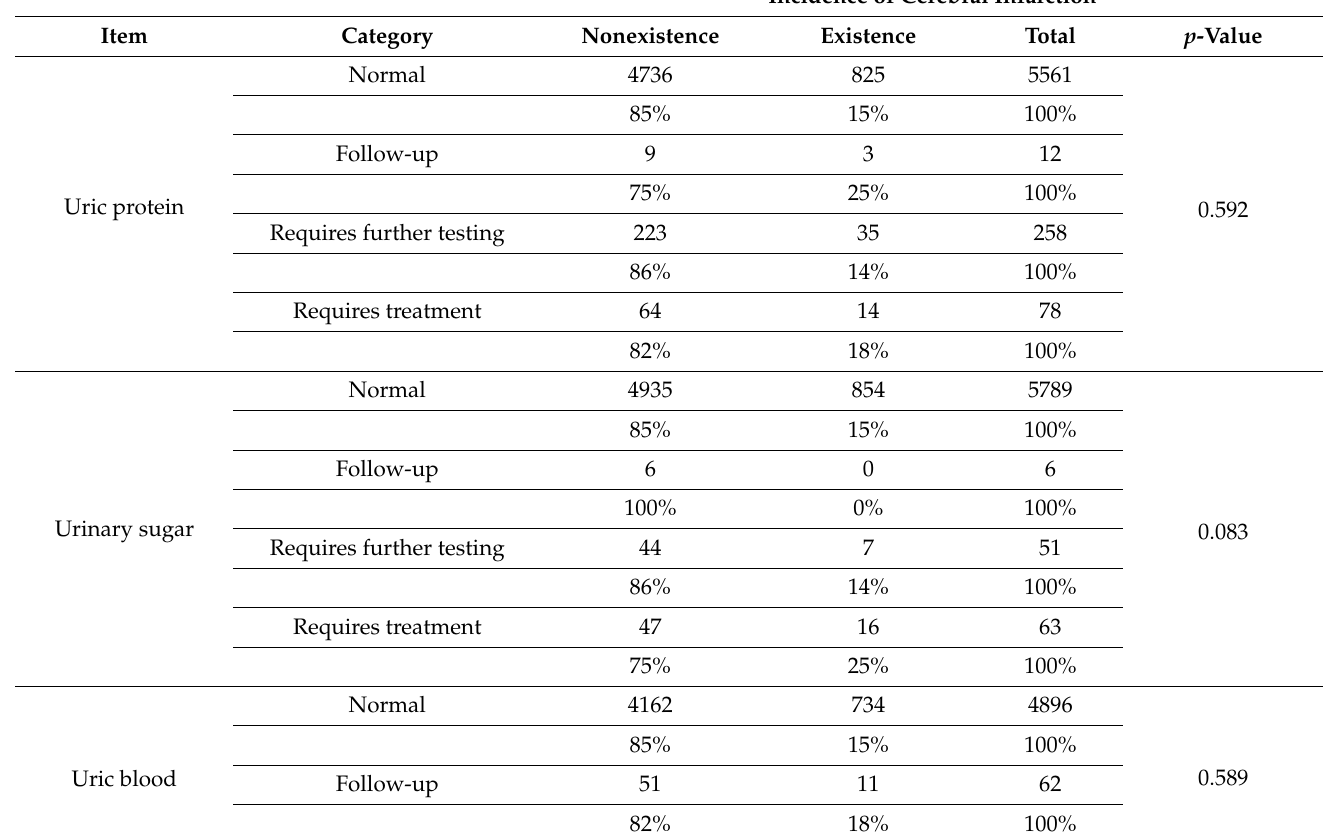
Table 1. Cross-tabulation results of the biochemical tests in 2009 and incidence of cerebral infarction in 2019. Incidence of Cerebral